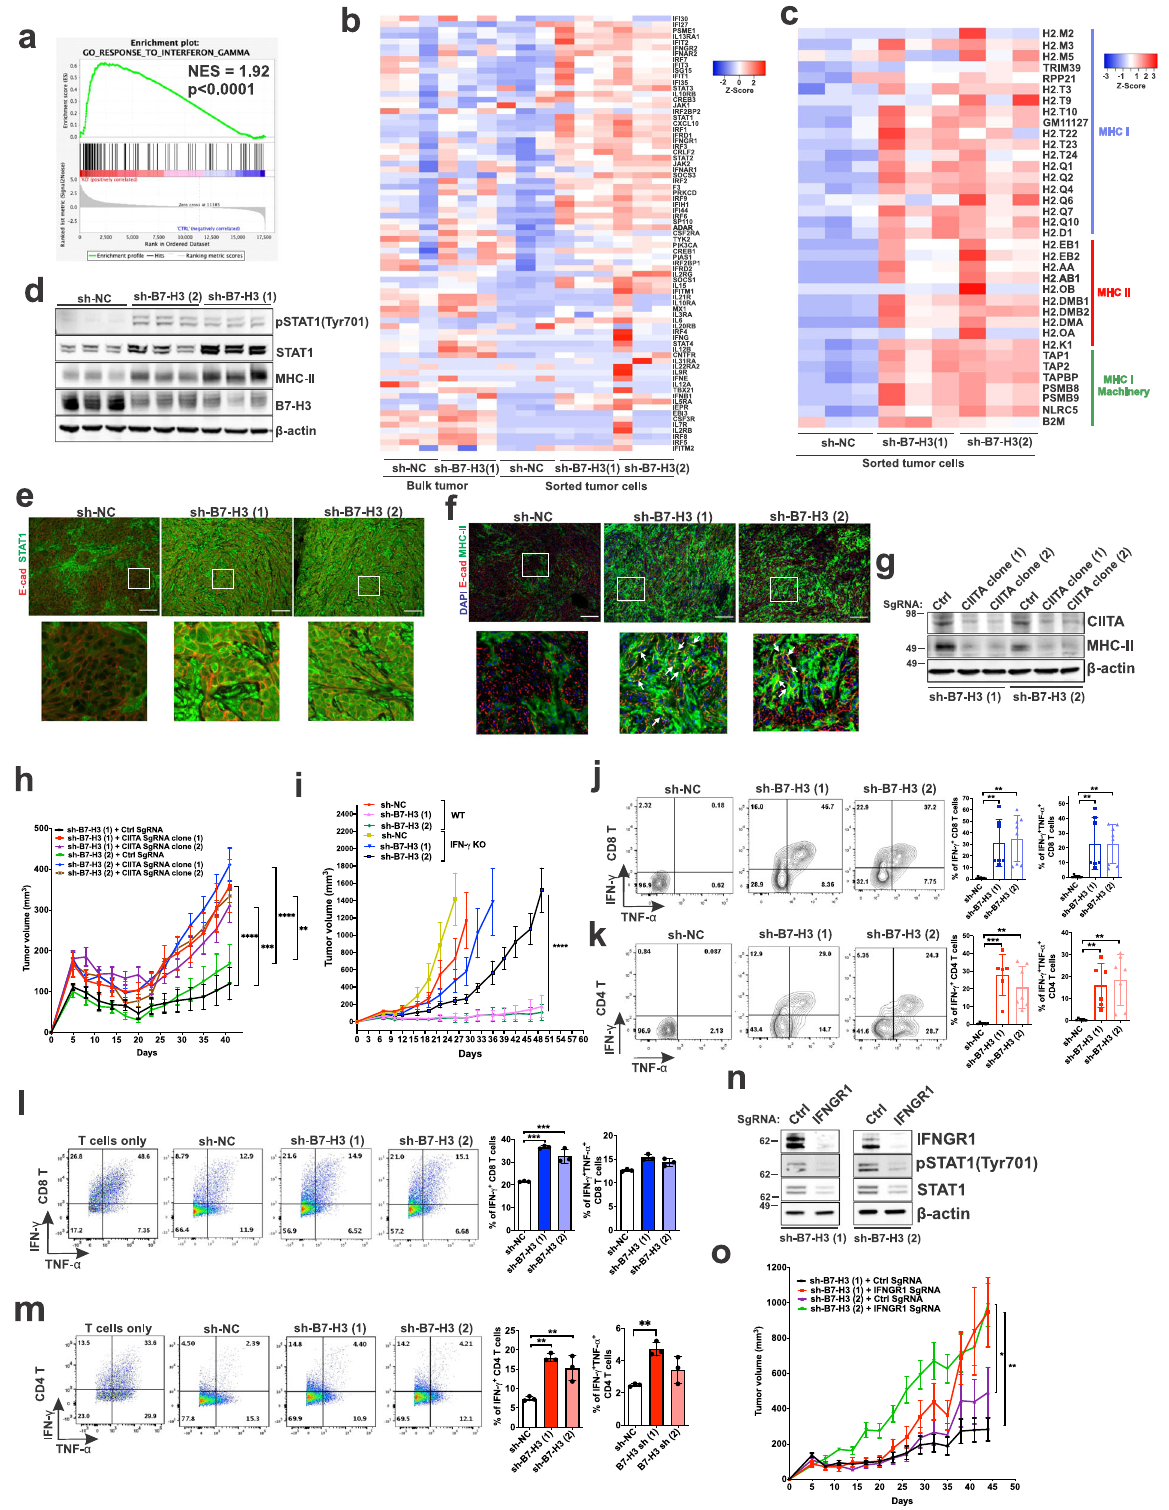
H3 knockdown tumors grew faster in Cd4 KO mice than Cd8 KO mice (Supplementary Fig. 6e), with tumor size ~4-fold larger in Cd4 KO mice vs. control mice, and ~2.7-fold larger in Cd8 KO mice